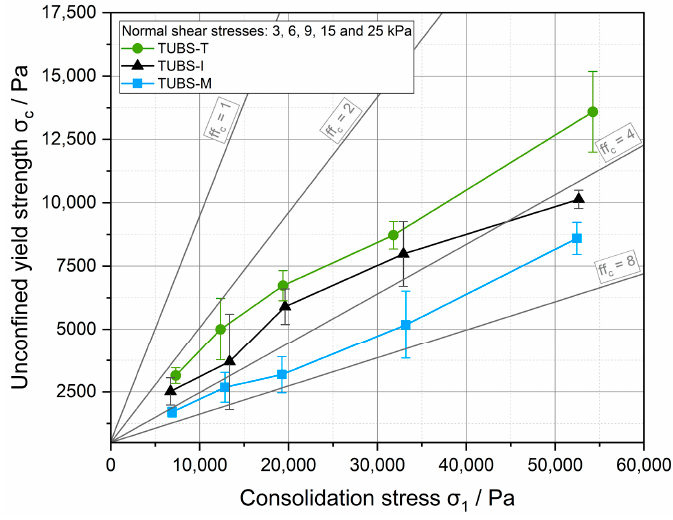
Figure 12. Flow behavior of the three regolith simulants at different shear stresses.